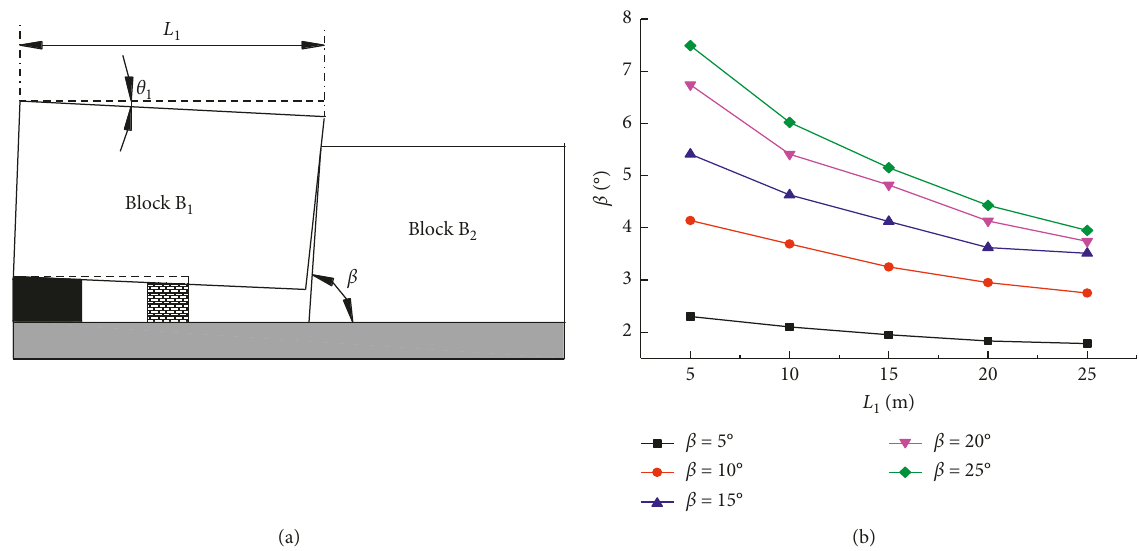
Figure 2: Relationship among rotation angle, cutting angle, and cutting position. (a) Geometric relationship between blocks; (b) relationship between the rotation angle and cutting